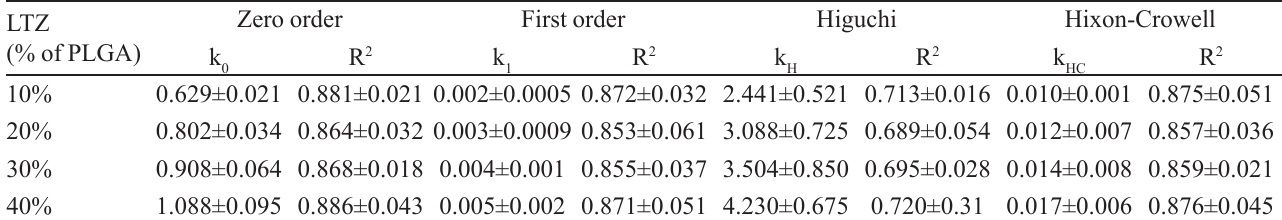
TABLE II - Release rate constants k, Correlation coefficients (R 2 ), mean ± SD, (n=3) calculated after fitting the release profiles to mathematical models